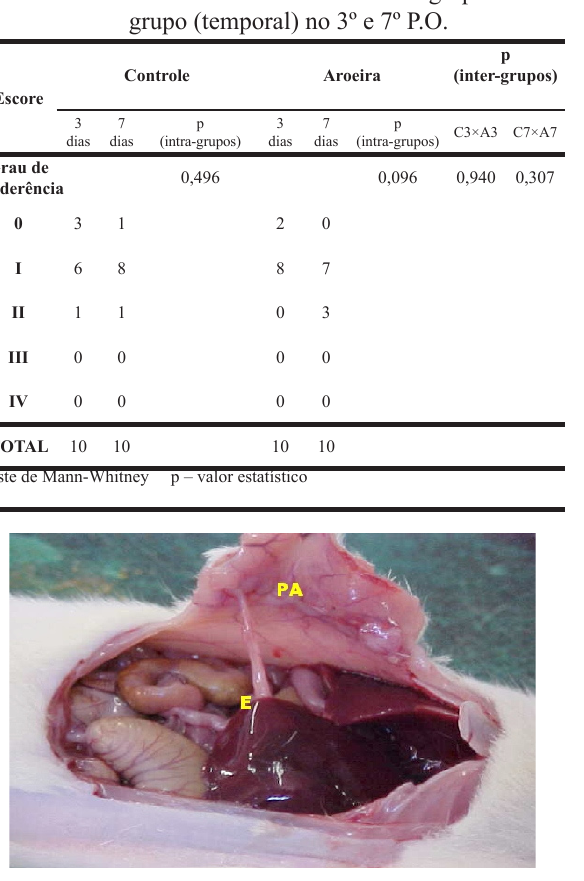
FIGURA 3 – Aderência grau I. Legenda - Rato 28, GC,